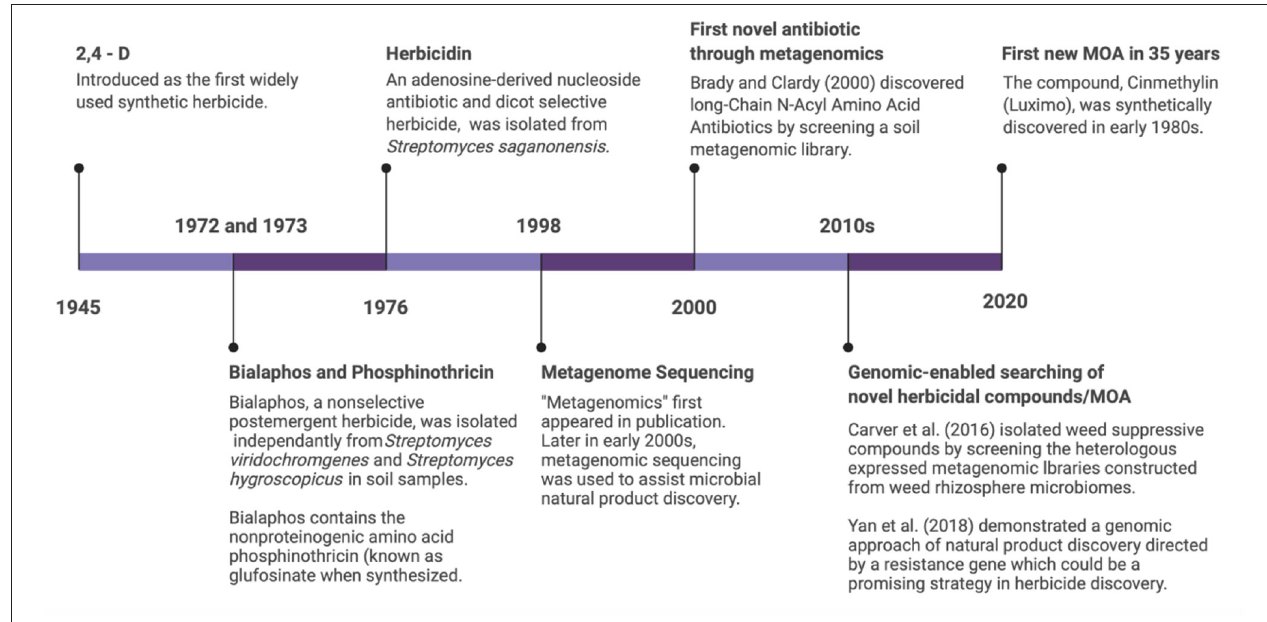
FIGURE 2 | Timeline of herbicide development indicating synthetic, natural, and genomics-enabled screening tools. Chemical synthesis approaches have stagnated since the start of the twenty-first century, while microbial natural product discovery and genomics show promising applications in weed